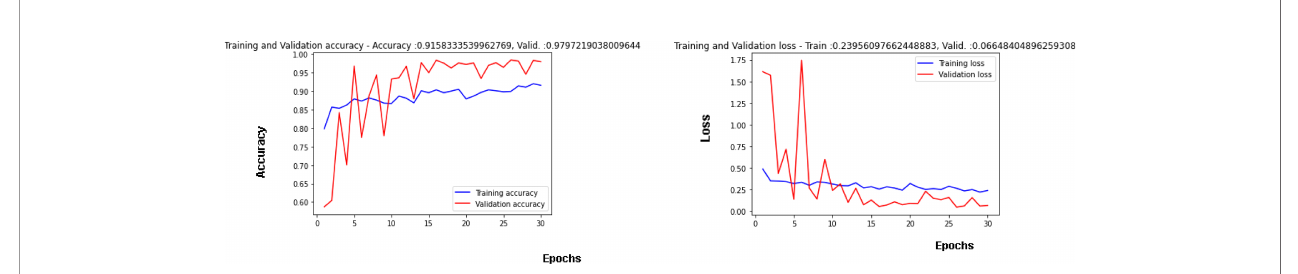
FIGURE 7 | Training and Validation Curves using RMSprop Optimizer: (A) Accuracy, (B) Loss.